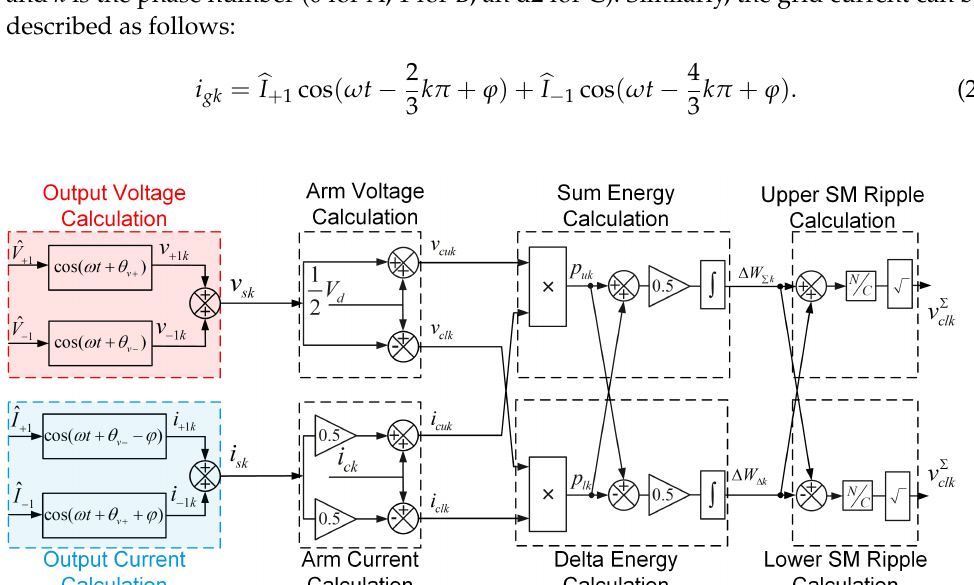
Figure 2. Block diagram of the analytical derivation of the submodule-capacitor